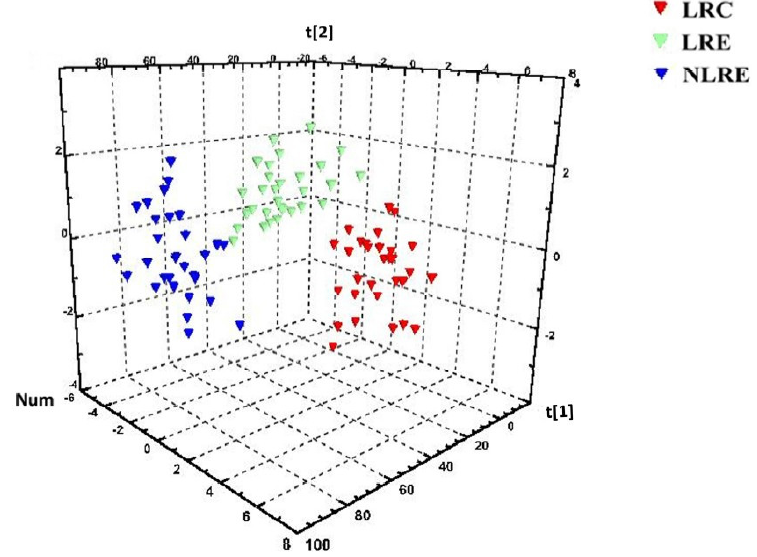
Figure 2. Scores plot from the partial least squares ‐ discriminant analysis of overall indexes including the metabolites and elements in the three groups. Red symbols represent the participants in the LRC group. Green symbols represent the participants in the LRE group. Blue symbols represent the participants in the NLRE group. Their spatial distribution reveals the variations of the metabolites and element profiles among the three groups. The three groups exhibit a clear separation, indicating that there are differences in the metabolites and element profiles among the three groups. LRC, centenarians from longevous region; LRE, elderly people aged 80 – 99 years from longevous region; NLRE, elderly people aged 80 – 99 years from a non ‐ longevous region.